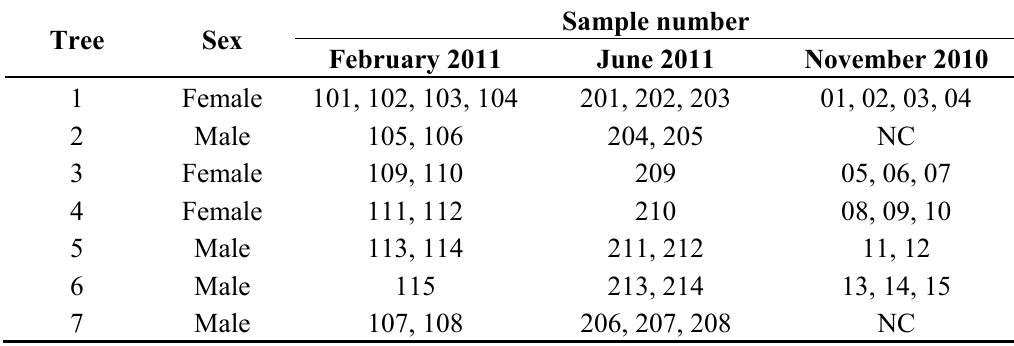
Table 1. Resin samples collected from Austrocedrus chilensis trees according to plant sex and seasons. February, n = 15; June, n = 14; November, n = 15. NC: not collected.